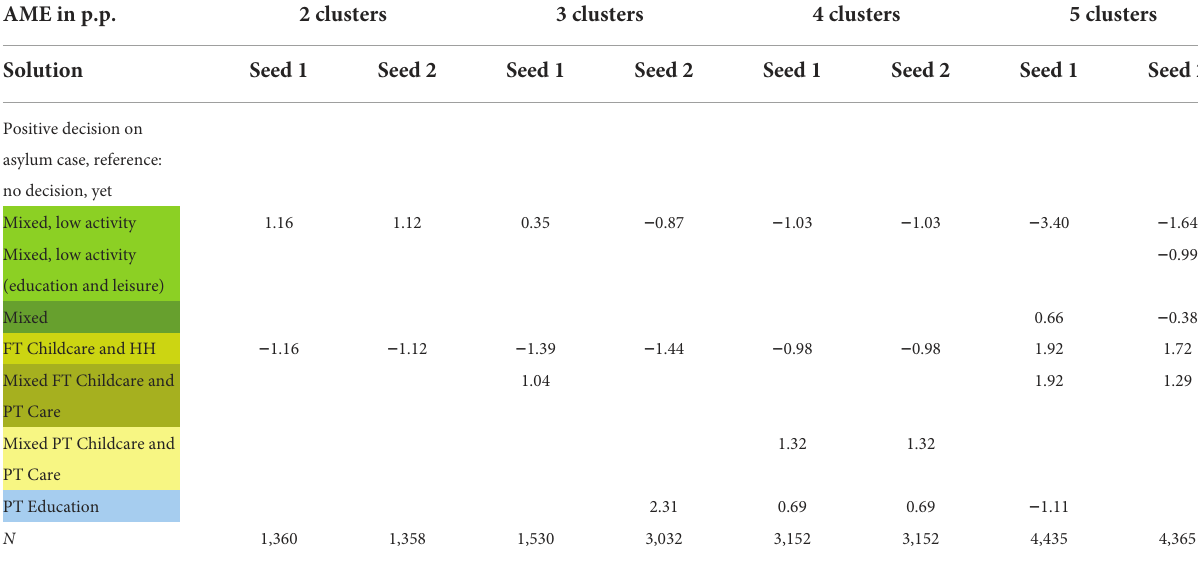
TABLE 6 Fixed effects analyses: the role of refugees’ legal status. AME in p.p.